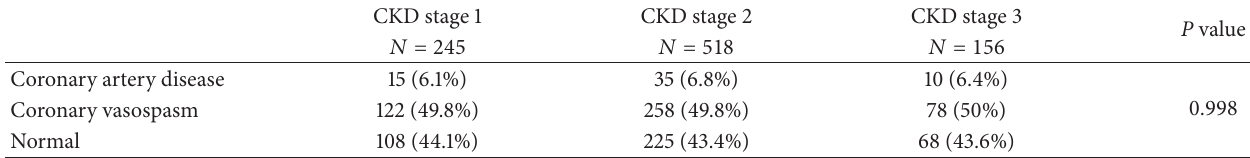
Table 1: Percentage of normal patients and patients with CAD and vasospasm according to chronic kidney disease stage.